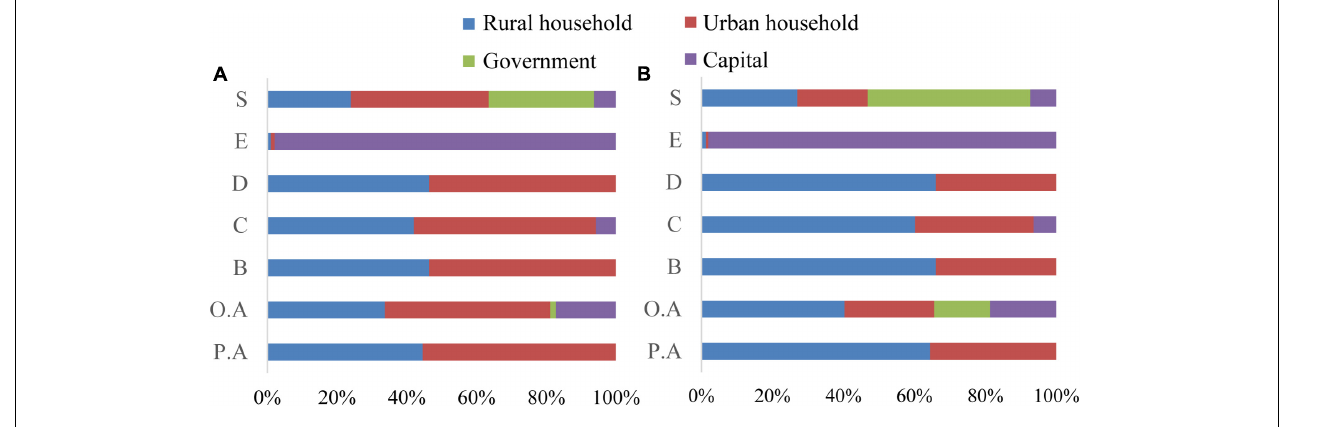
Frontiers in Ecology and Evolution |